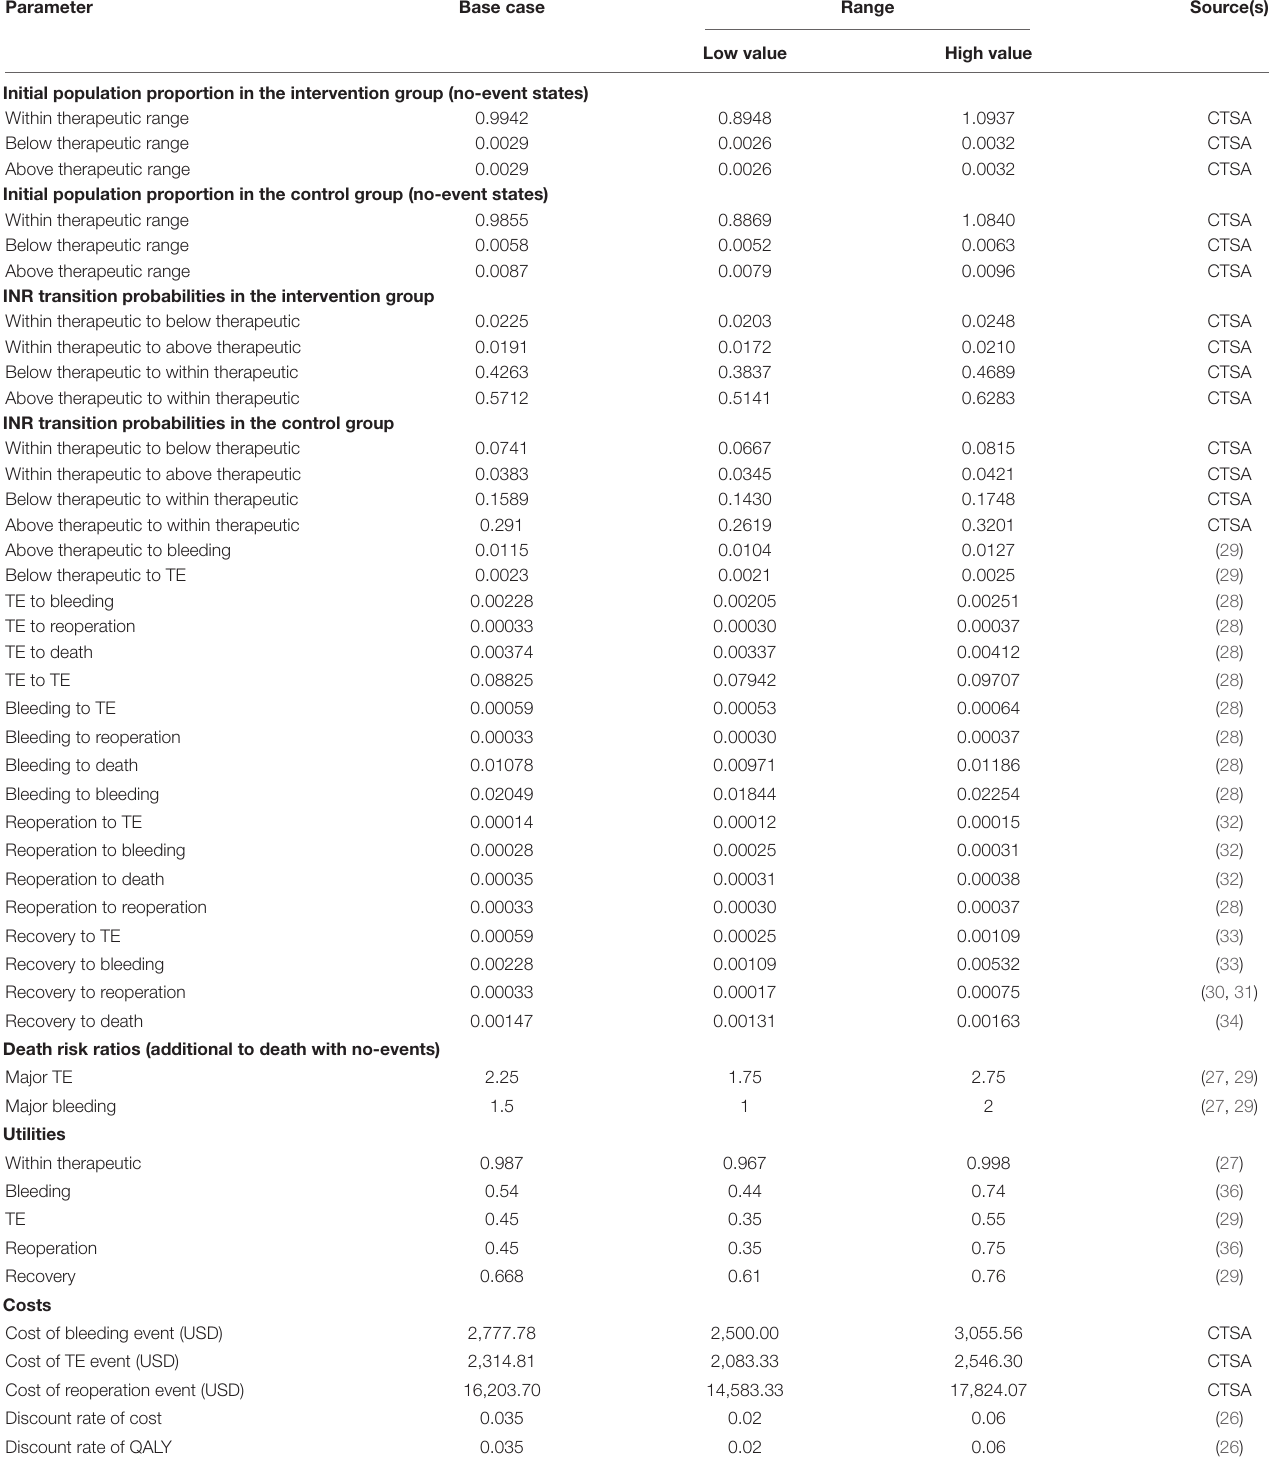
TABLE 1 | Model inputs and data sources for the cost-effectiveness